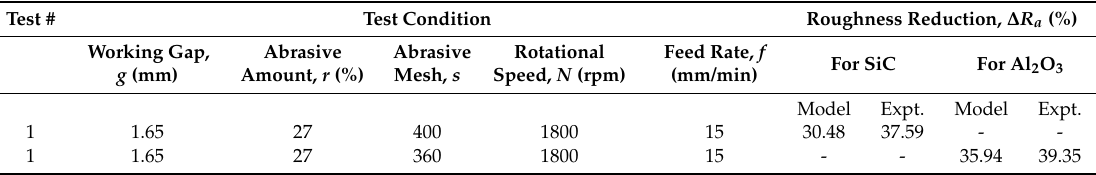
Table 7. Confirmation tests for mathematical model for ∆ R a